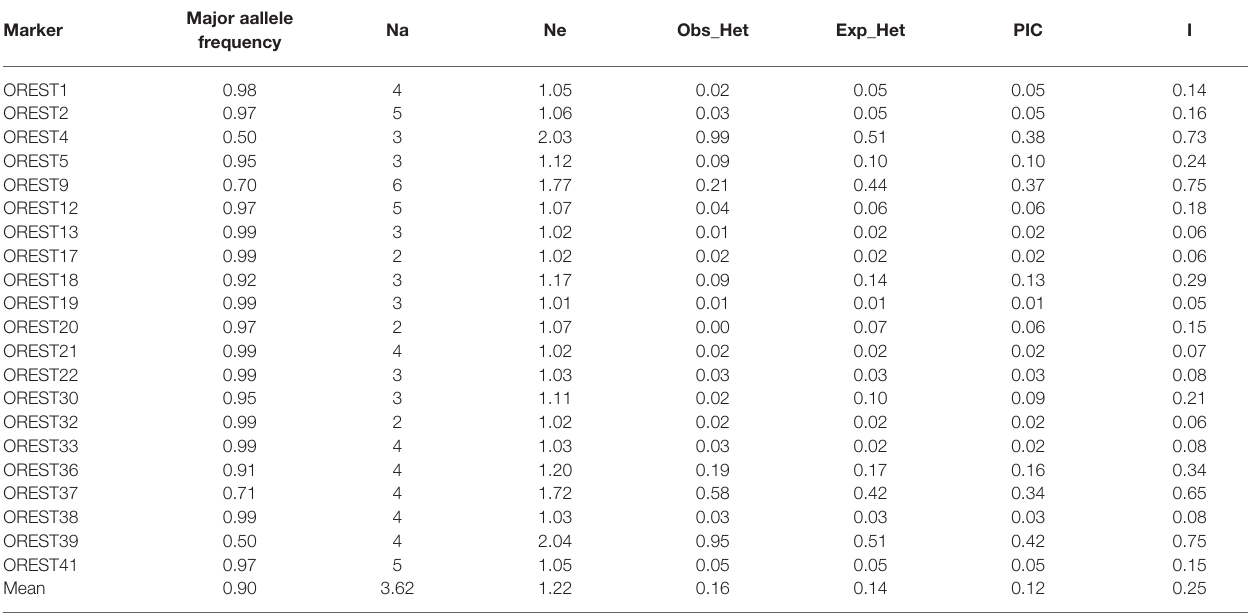
TABLE 2 | Analysis of 21 new Expressed Sequence Tag-Simple Sequence Repeat (EST-SSR) markers in 153 Abelmoschus esculentus accessions. Major aallele Marker Na Ne Obs_Het Exp_Het PIC I frequency